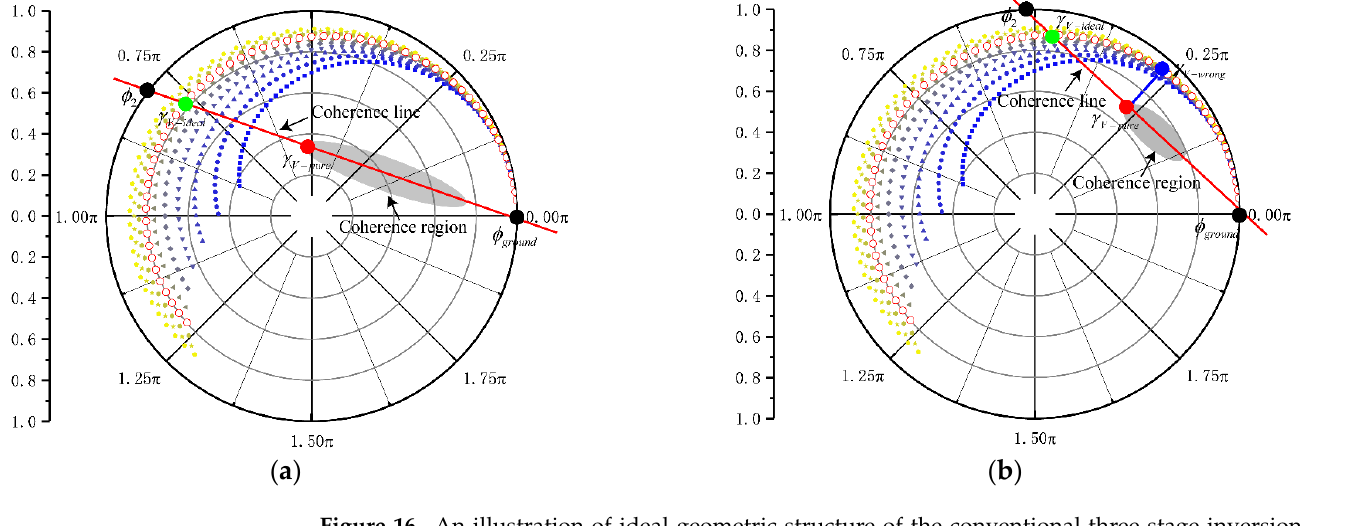
Figure 16. An illustration of ideal geometric structure of the conventional three-stage inversion method and the situation of a failed geometric structure. ( a ) The ideal geometry of the traditional three-stage inversion method. ( b ) Either the coherence region’s long axis is too short or too far away from the LUT for the geometric structure to fail.